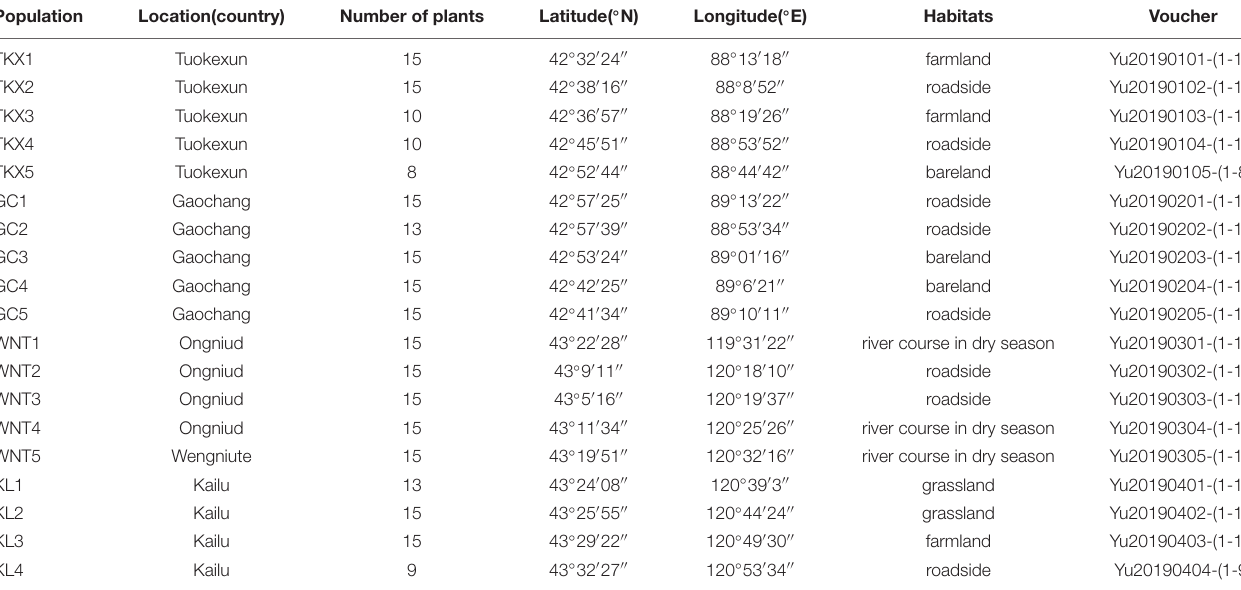
TABLE 1 | Origin of materials and number of samples for different populations of Solanum rostratum in China. Population Location(country) Number of plants Latitude( ◦ N) Longitude( ◦ E) Habitats Voucher